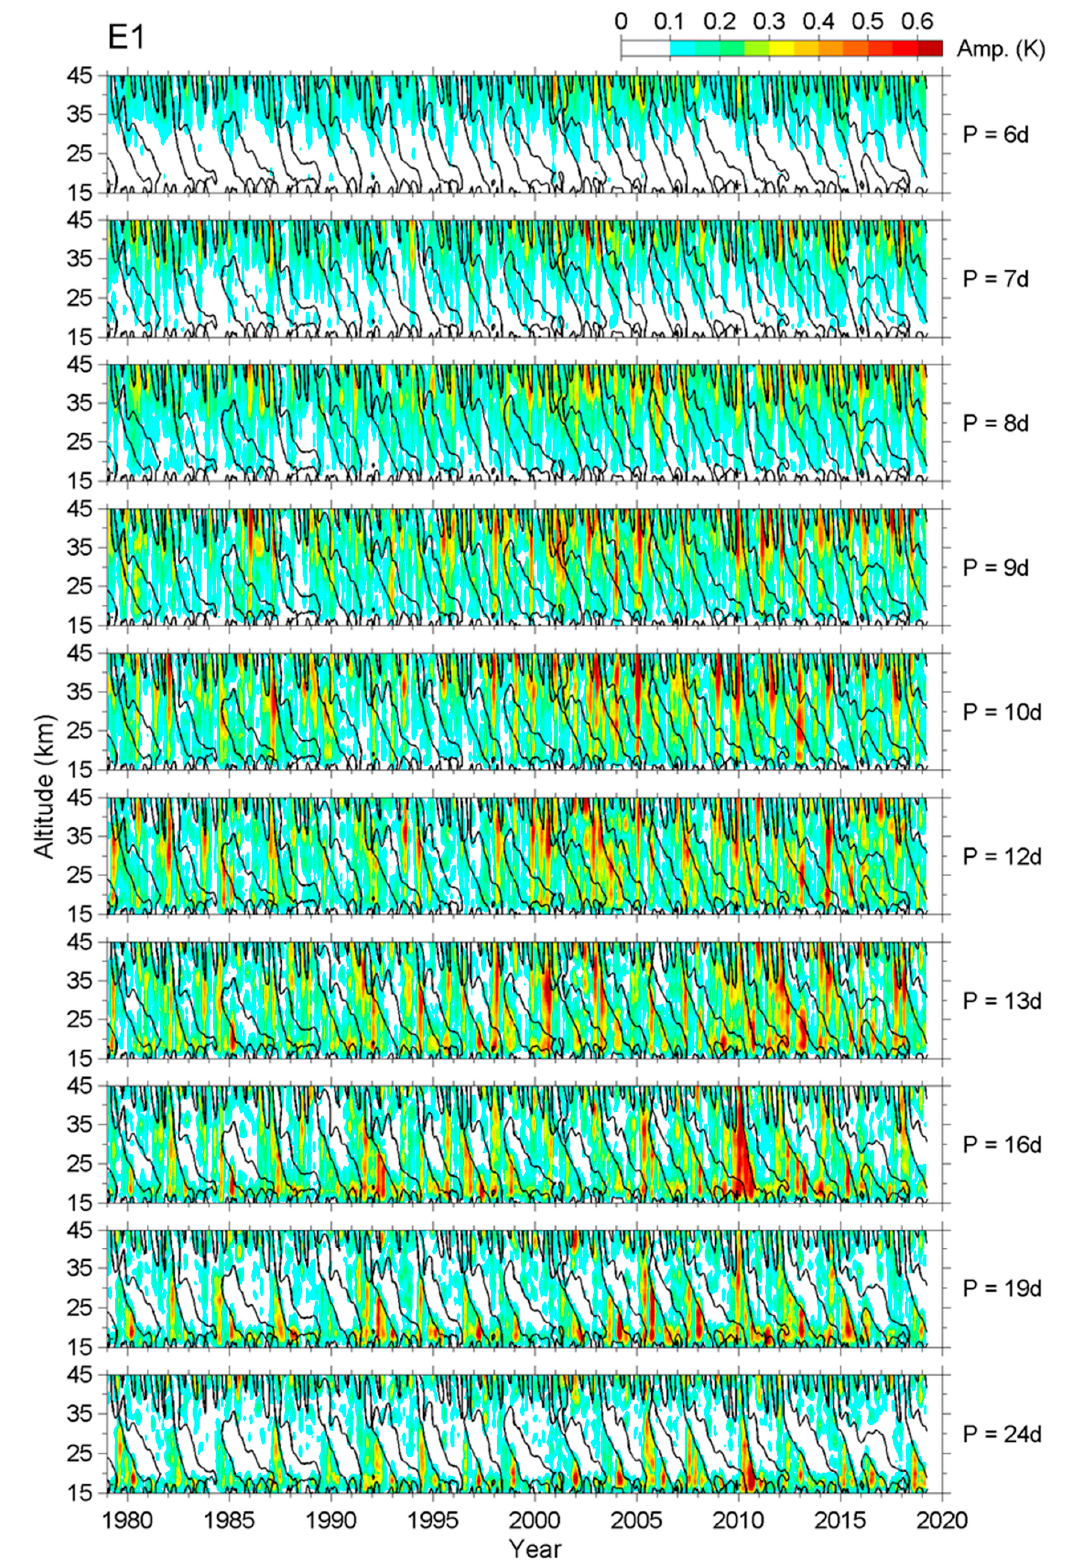
Figure 3. The amplitudes of E1 waves as a function of time and altitude. Each panel plots the amplitude at the wave period specified on the right-hand side of the panel. The zero-wind contours are also plotted by black lines.